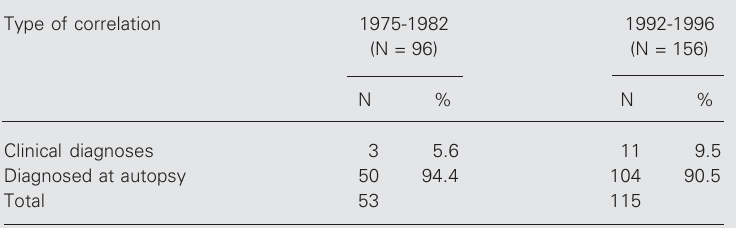
Table 5. Frequency of iatrogenic lesions found at autopsy and correlation with clinical diagnoses during two different periods (Faculdade de Medicina de Botucatu, São Paulo, Brazil).